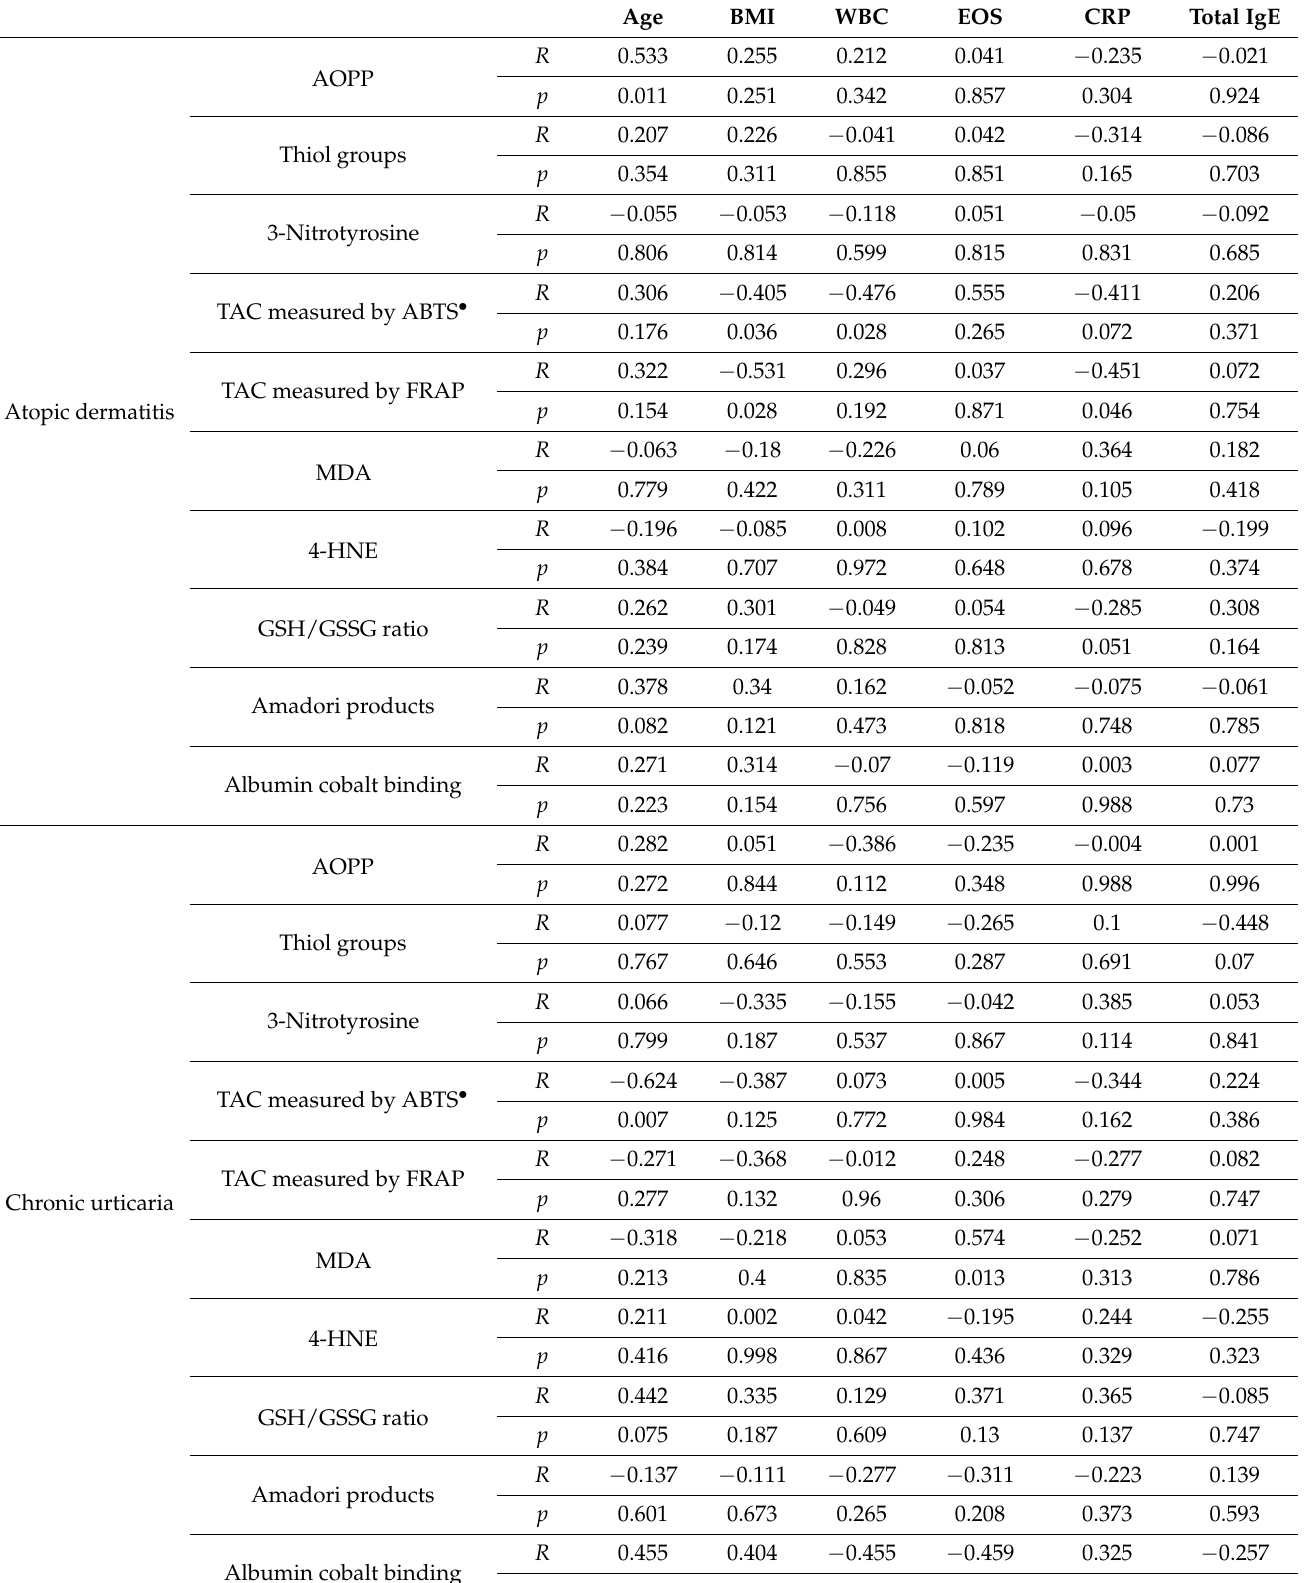
Table 3. Spearman’s rank correlation coefficients and p values a